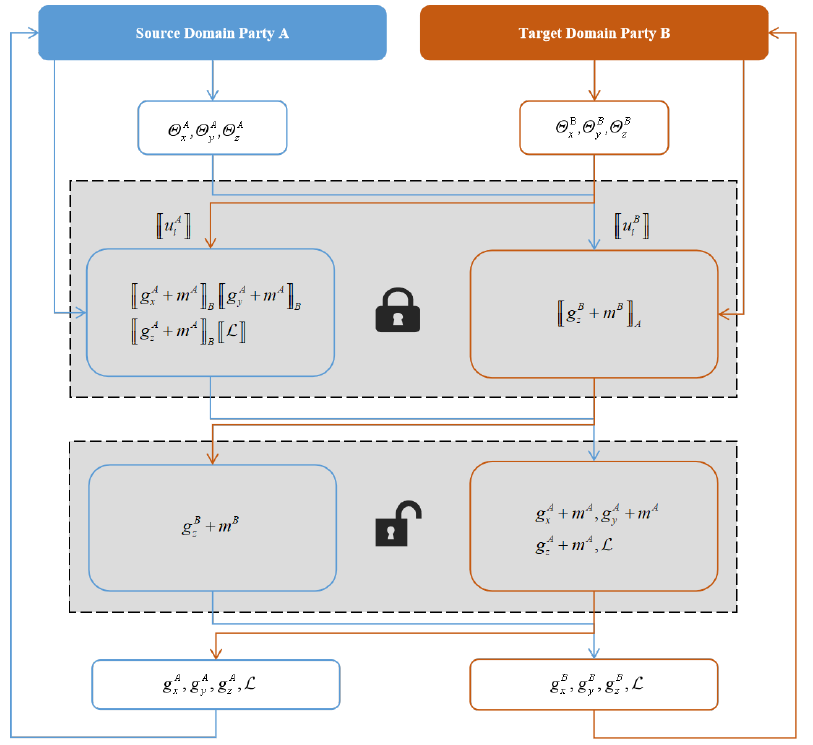
Figure 2. System Architecture of Federated Domain Adaptation. Algorithm 1 Federated domain